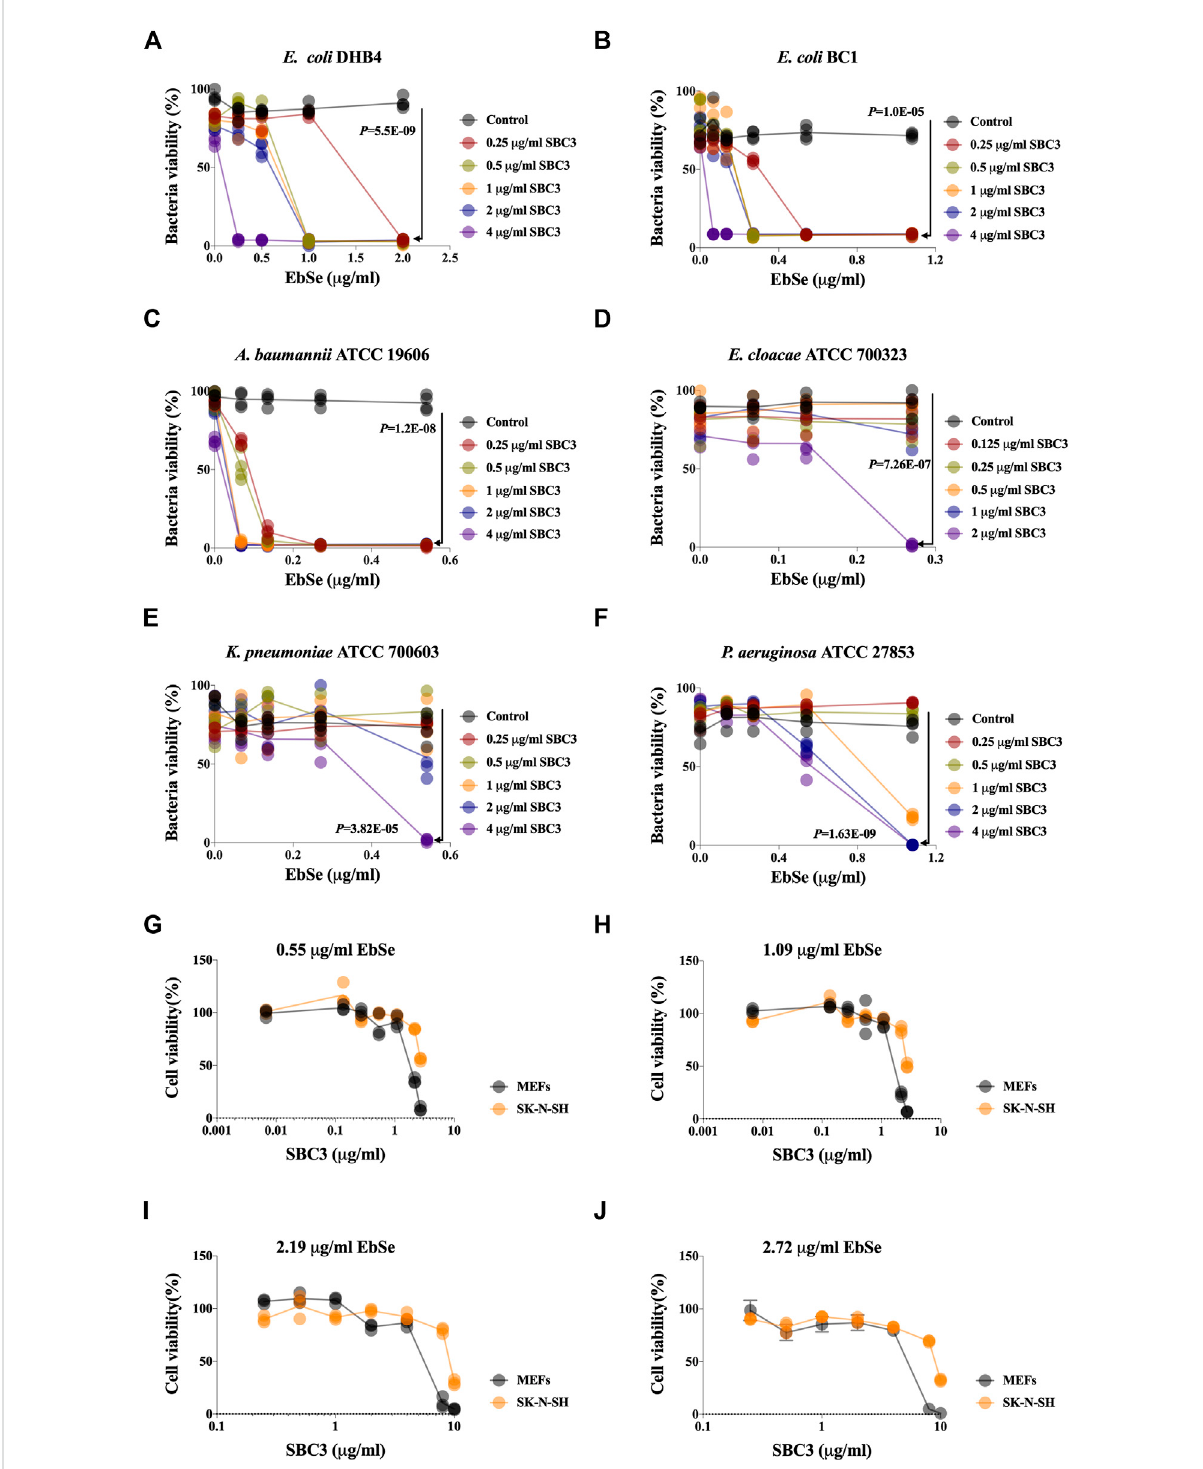
Effects of SBC3 in combination with Ebselen on the growth of bacteria and mammalian cells. (A – J) Bacteria overnight cultures were diluted 1: 1,000into100 μ LofLBmediumin96micro-wellplatesandtreatedwith100 μ LserialdilutionsofSBC3andEbselen. (A) E.coli DHB4. (B) E.coli BC1. (C) A. baumannii ATCC 19606. (D) E. cloacae ATCC 700323. (E) P. aeruginosa ATCC 27853. (F) K. pneumoniae ATCC 700603. (G – J) The toxicity of SBC3 and Ebselen on thegrowth ofMEFs and S-KN-SH. Cells weretreated with serial concentrationsof SBC3 and Ebselen for 24 hand